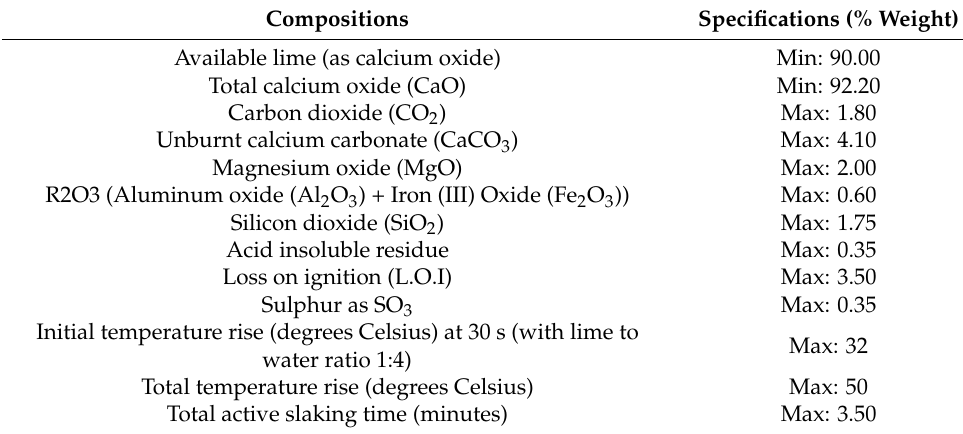
Table 2. Quicklime properties used in this study.